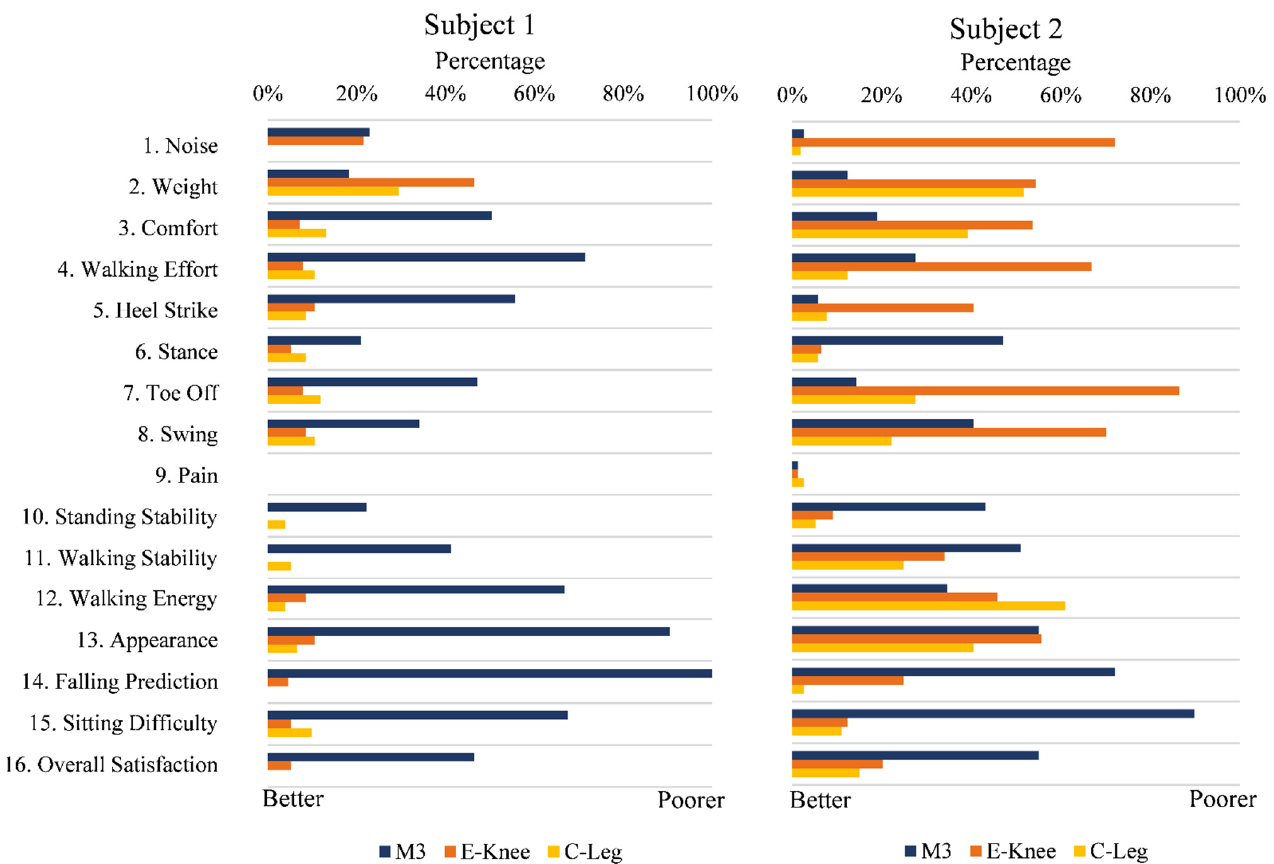
Figure 4. LFPQ responses for M3, E-Knee, and C-Leg for both Subject 1 ( left ) and Subject 2 ( right ). Responses recorded along a line are represented as percentages of the whole line length; increase in percentage represents poorer outcome.